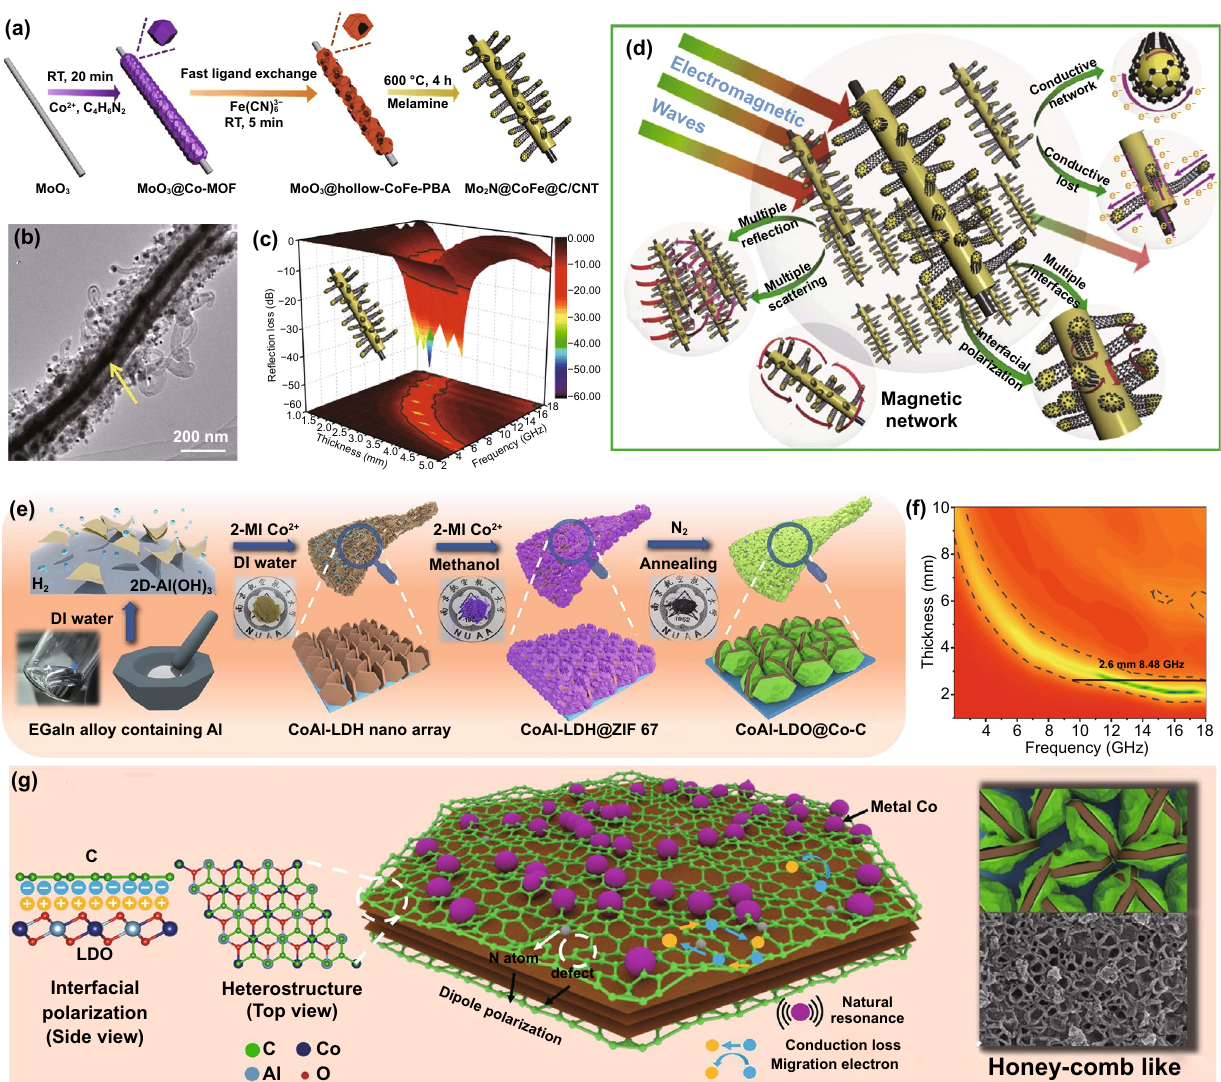
Fig. 17 a Schematic representation of the synthesis, b TEM image, c 3D RL-f curves and d MA mechanism of Mo 2 N@CoFe@C/CNT. Reprinted with permission from Ref. [164]. e Schematic description for preparation route, f 2D RL-f mapping and g MA mechanism of CoAl- LDO@Co-C. Reprinted with permission from Ref.